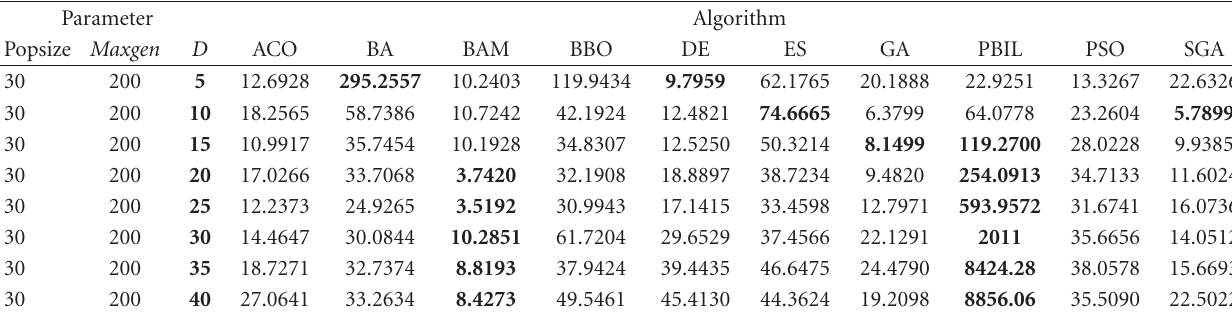
Table 7: Worst normalized optimization results on UCAV path planning problem on di ff erent D . The numbers shown are the worst results found after 100 Monte Carlo simulations of each algorithm.